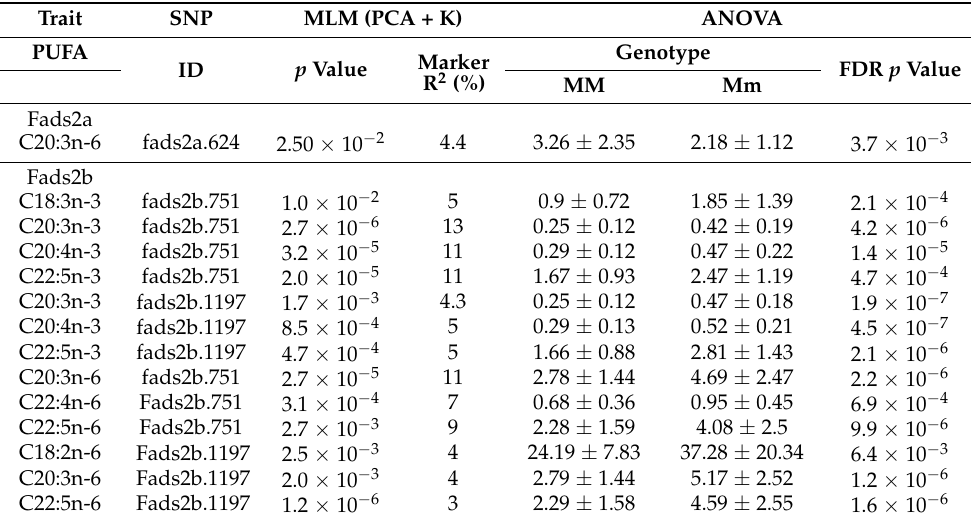
Table 4. Association analysis of PUFA contents using MLM and ANOVA. Trait SNP MLM (PCA + K) ANOVA Genotype PUFA FDR p Value ID p Value Marker R 2 (%)